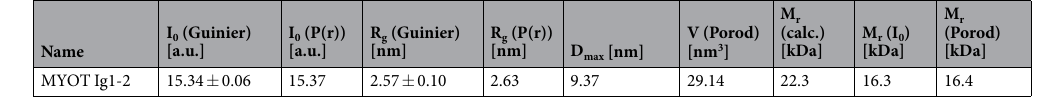
Table 1. Parameters derived from the SAXS data for